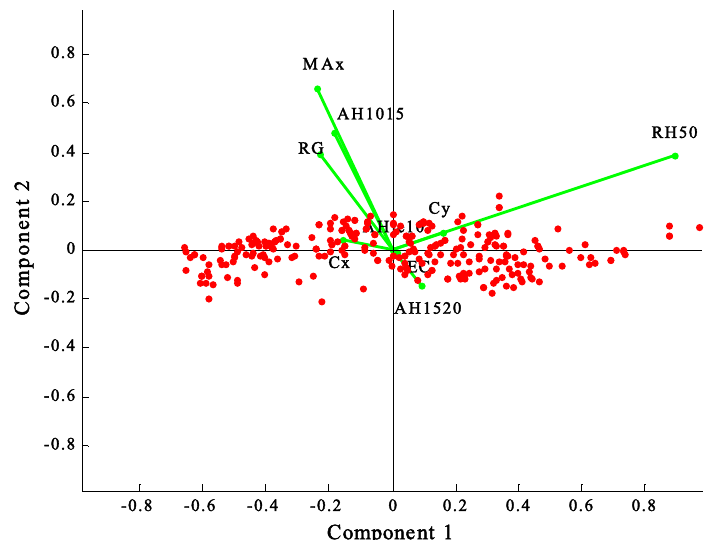
Figure 6. Age-attribute mapping with different metric combinations corresponding to that learned with RNAA metrics shown in Table 3. The color bar represents the relative score scaled to range from 0 to1.